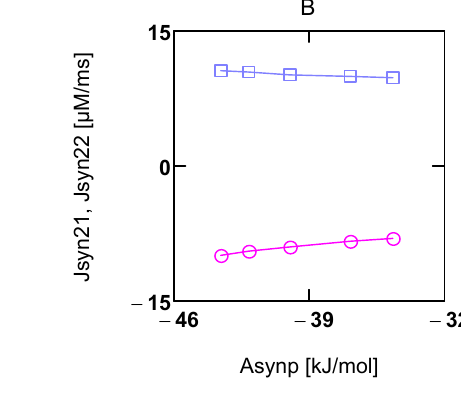
J and h J are both uncoupled by SY SY